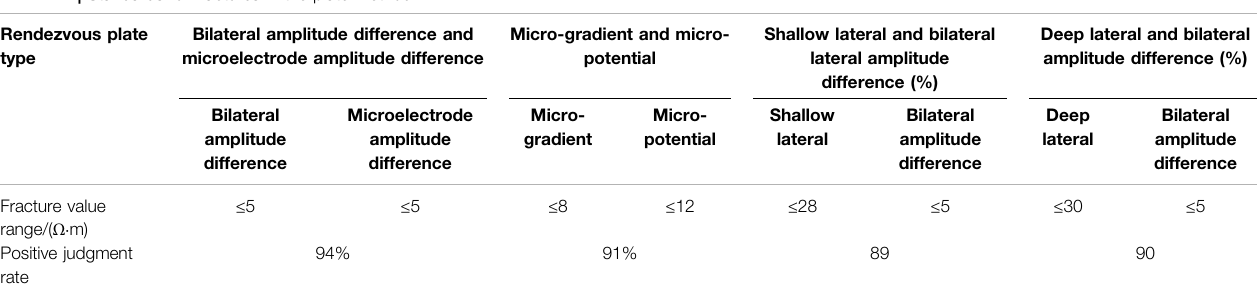
TABLE 2 | Standards for fractures in the plate